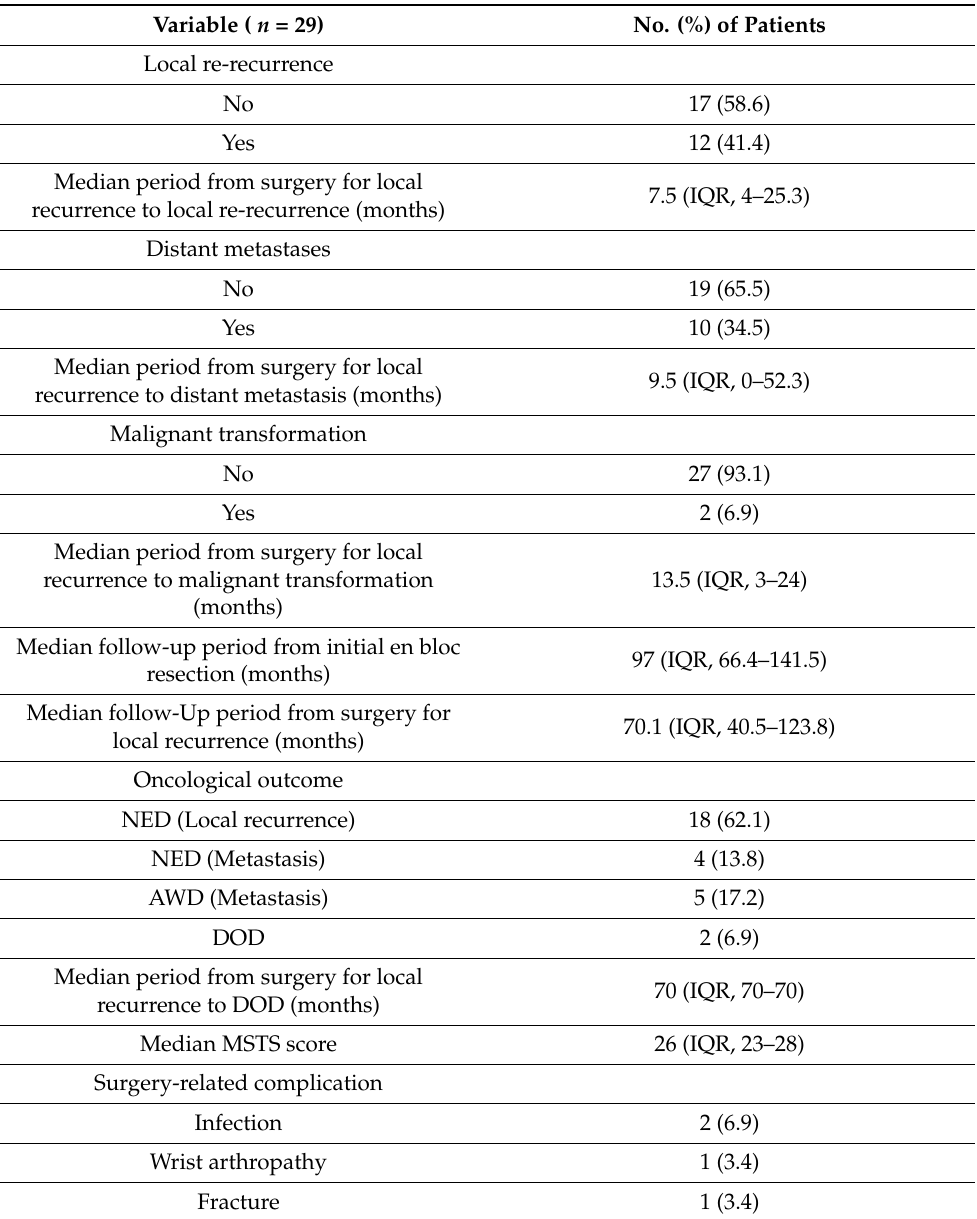
Table 2. Patients’